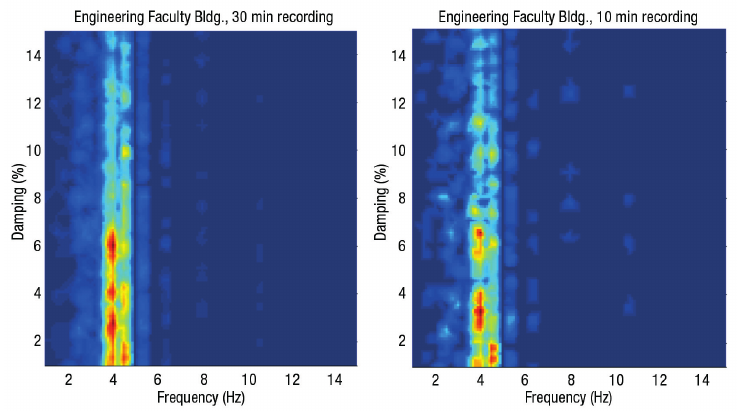
Fig. 3. NonPaDAn estimate of frequency and damping as a function of recording length ( left : 30 min; right : 10